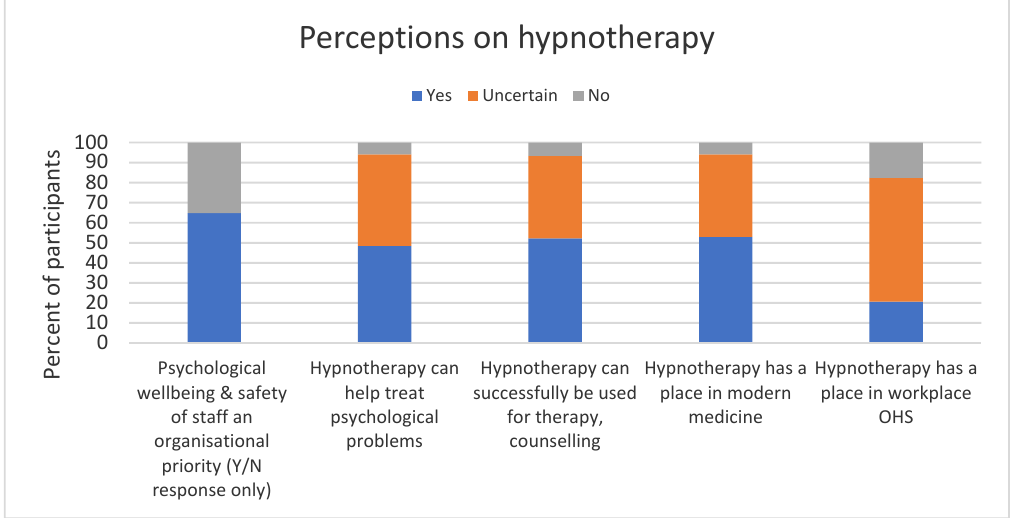
Figure 2. Perceptions regarding hypnotherapy.